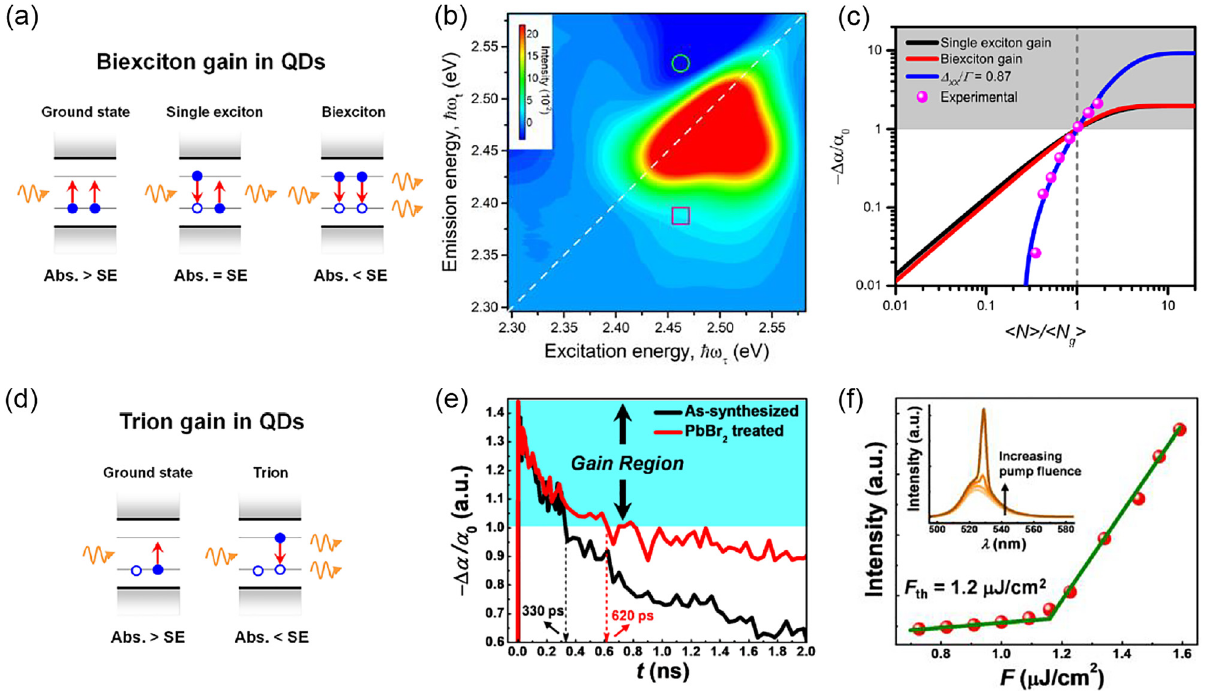
Figure 9: (a) Mechanism for the biexciton gain in a neutral perovskite nanocrystal. (b) Absorptive 2DES spectra of CsPbBr 3 nanocrystals recordedatapopulationtimeof5psunderpumping fl uenceof25 μ Jcm − 2 .(c)Exciton-density-dependentgaingeneration.Thesolidlinesshow the simulated − Δ α / α 0 using three different models. The magenta circles indicate the signal data (2.46 and 2.39 eV) obtained in